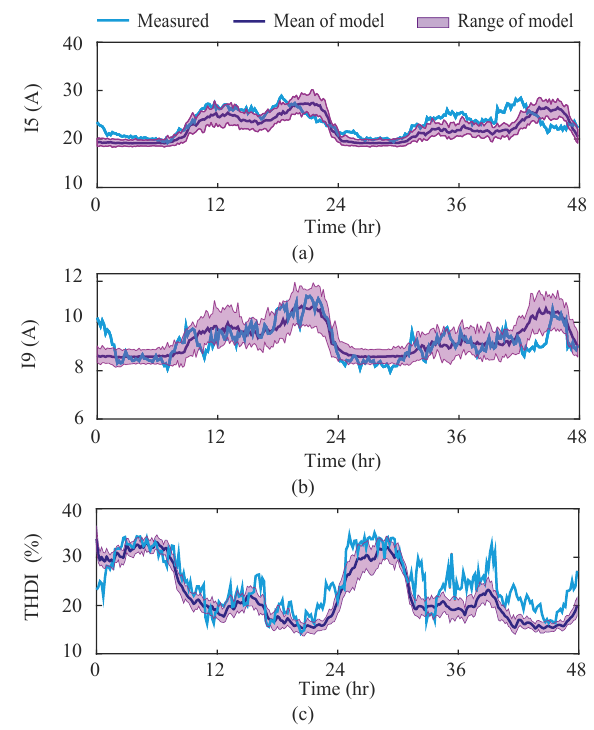
Figure 10. Comparison of the measured and the mean of simulated results of current magnitudes ( N MC values at each time instance) ( a ) 5th; ( b ) 9th; and ( c ) total harmonic distortion of current ( THDI ).